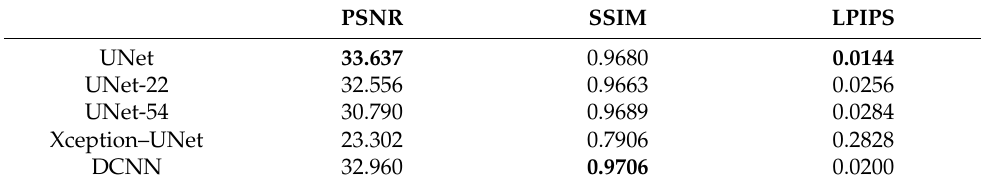
Table 2. Comparison between UNet, UNet-22, UNet-54, Xception–UNet, and DCNN based on the PSNR, SSIM, and LPIPS in the colorization task. The best values of PSNR are 33.637, SSIM is 0.9706, and LPIPS is